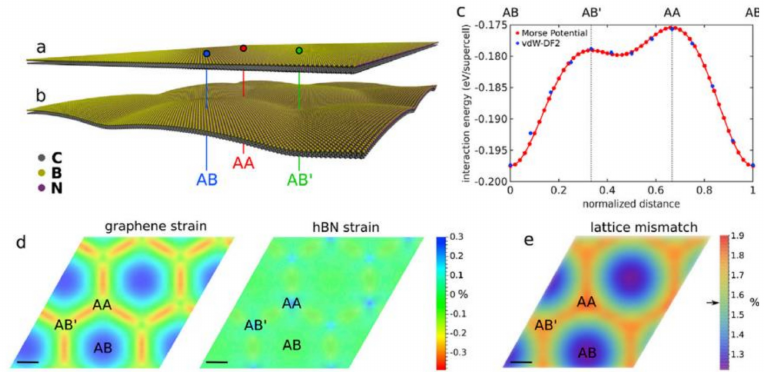
Figure 11. The electrical characteristics of a graphene/hexagonal boron nitride bilayer. ( a ) layer of graphene/h − BN bilayer before stress, ( b ) graphene/h − BN bilayer structural model after full relaxation, ( c ) the interlayer binding energy curve for each super monomer, ( d ) strain maps for graphene and hexagonal boron nitride, and ( e ) lattice mismatch. (Reproduced from [246] with permission. Copyright 2017, Elsevier, Amsterdam, The